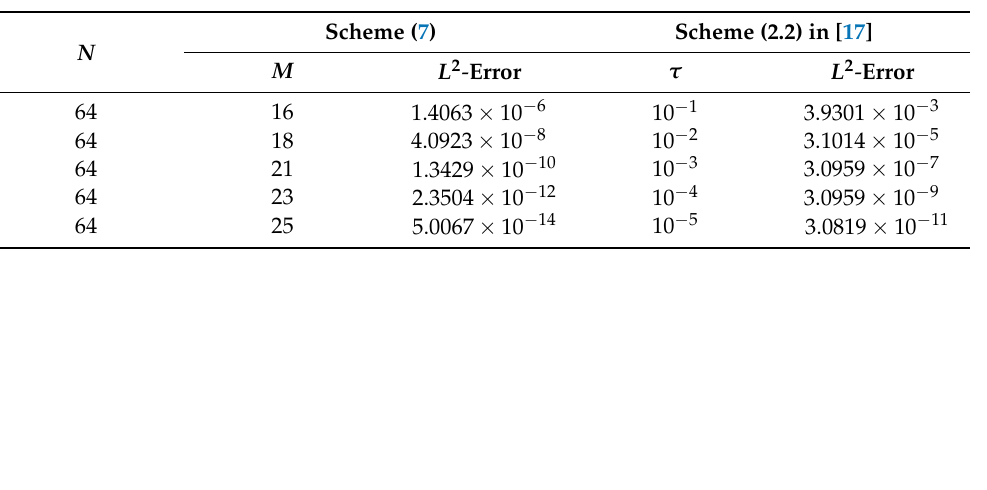
Figure 1. Time evolution of exact solutions and numerical solutions for Example 1. ( a ) Exact solutions u ( x , t ) = sin 2 ( π x ) sin ( 12 x + 12 t ) ; ( b ) numerical solutions u L ( x , t ) by scheme (7). Table 1. Temporal errors at t = 1 for Example